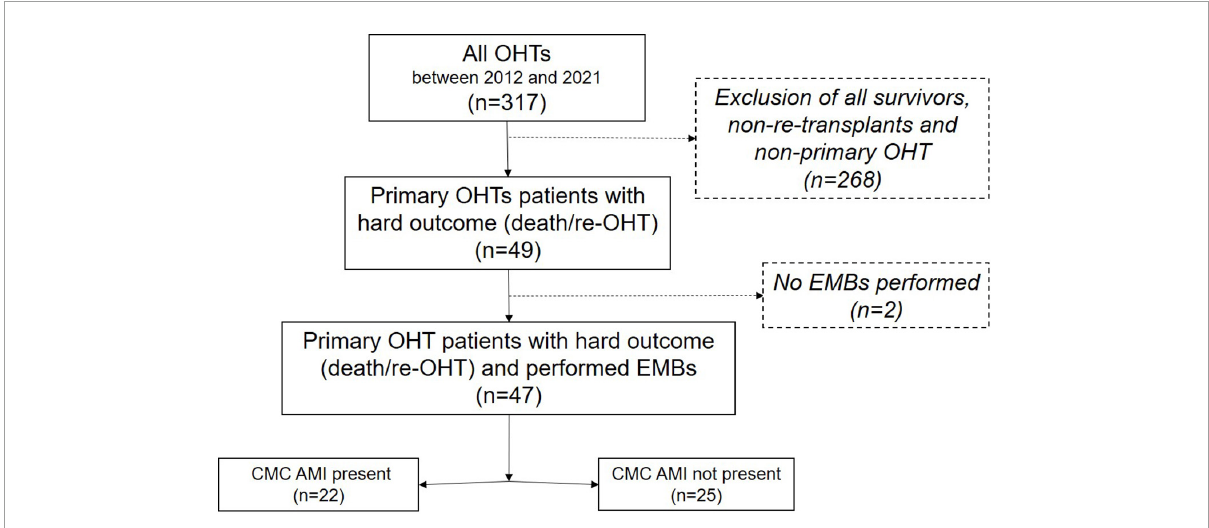
FIGURE1 Study flow chart. The patient population is included in this retrospective review, and their interventions and outcomes are summarized in this flow chart. OHT, orthotopic heart transplantation; CMC, cardiomyocyte; AMI, acute myocardial injury; EMB, endomyocardial